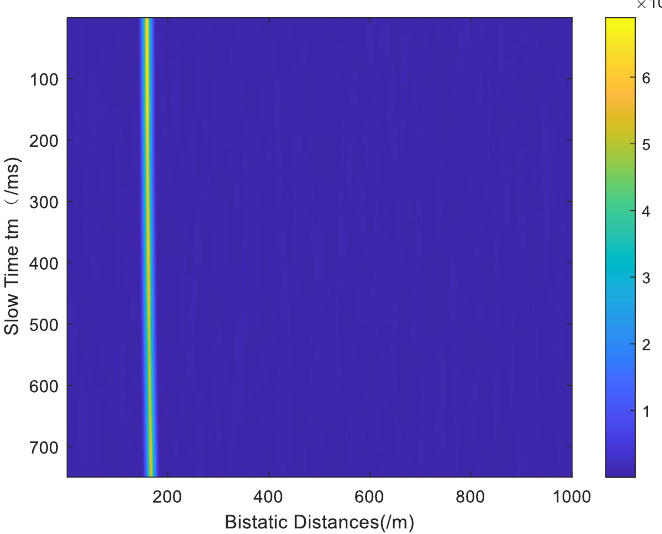
Figure 12. Signal Accumulation Result after Amplitude Correction.